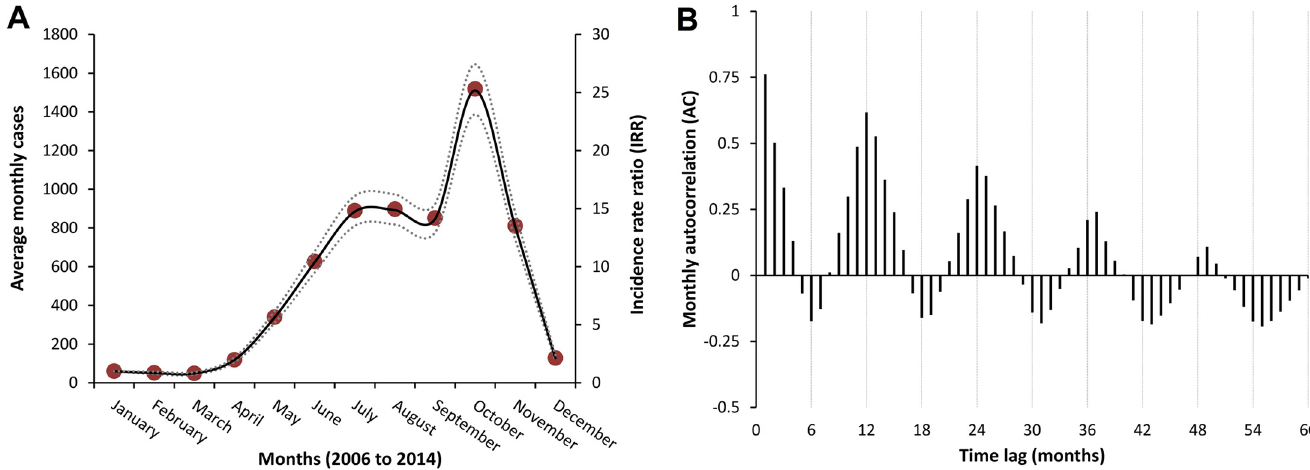
Fig 2. Seasonal patterns in reported scrub typhus cases from 2006 to 2014 in mainland China. The seasonal patterns of reported scrub typhus cases in mainland China are presented as the average number of cases reported by month (blue dots) and the incidence rate ratios (IRR) with 95% confidence intervals for the IRR (dashed and dotted lines) derived from a categorical Poisson regression models for the number of reported cases per month, with all months compared to the number of cases reported in January of each year in panel A. The seasonal patterns as determined by monthly autocorrelation between the number of reported cases for each month is presented using time lags between 0 and 60 months in panel